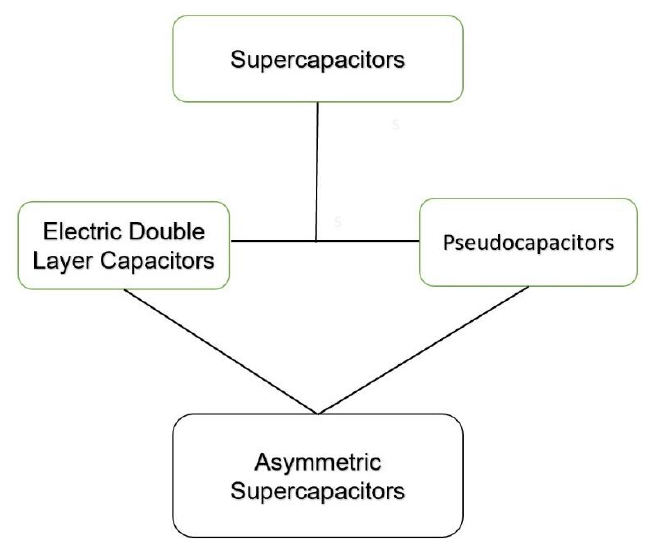
Figure 2. Schematic of types of supercapacitors. To avoid electrical contact, EDLC cells typically have two carbon-based electrodes specific surface area (1000 m 2 g − 1 ) are active materials for EDLCs [20]. In 1879, Helmholtz defined the energy storage mechanism for EDLCs, and Stern and Geary improved it